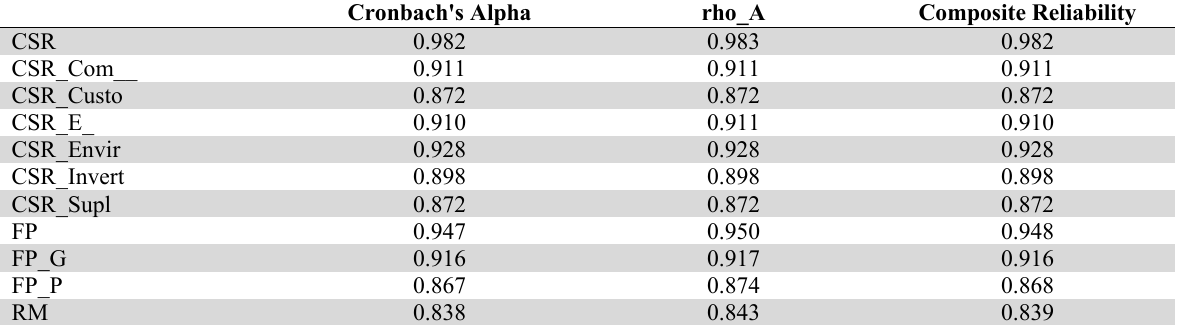
Construct Reliability and